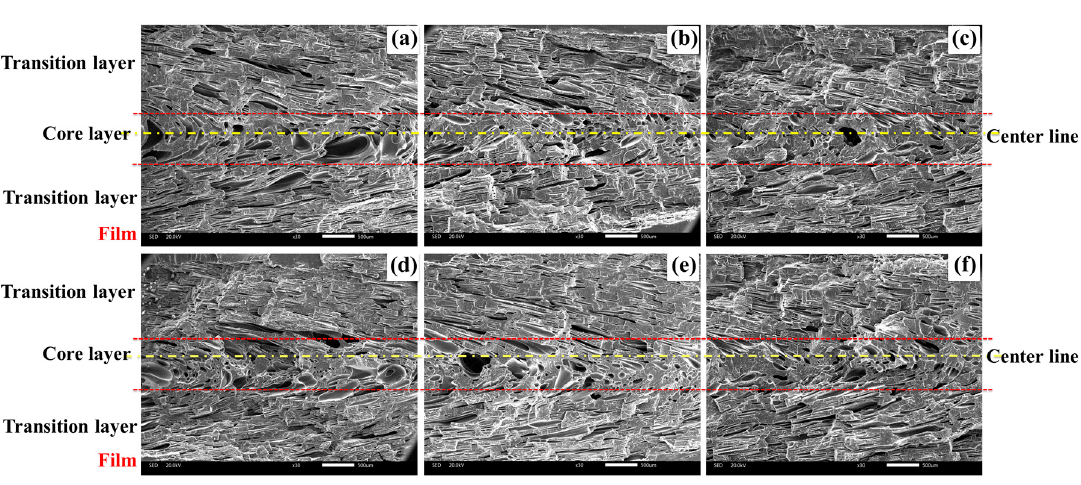
Figure 13. Cellular structure of foamed composites in parallel sections with di ff erent nano-CaCO 3 content: ( a ) 0 wt %; ( b ) 2 wt %; ( c ) 4 wt %; ( d ) 6 wt %; ( e ) 8 wt %; ( f ) 10 wt